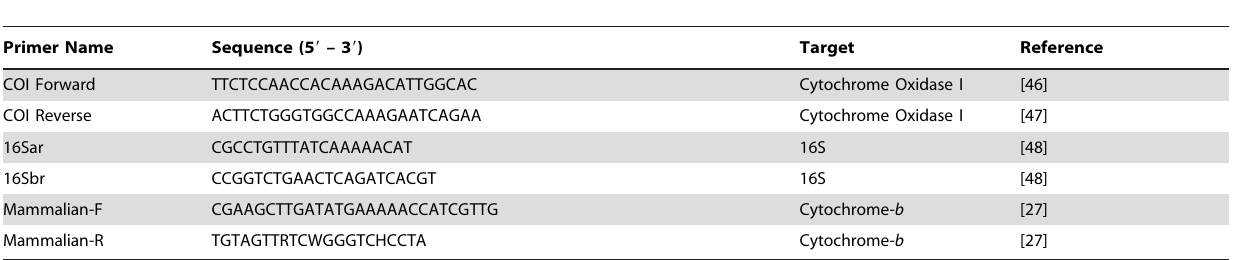
Table 1. PCR primers used to amplify mitochondrial DNA of mosquito blood